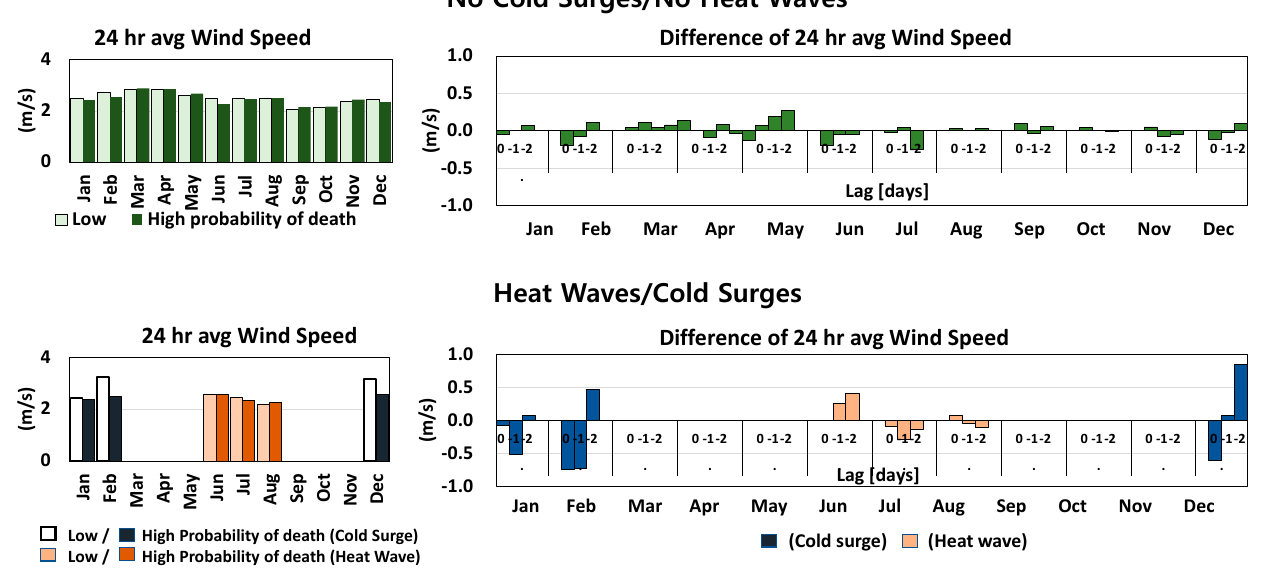
Figure 13. Comparison of monthly average precipitation on days of high and low probability of death and the differences in precipitation (precipitation (high probability of death) –precipitation (low probability of death) ) from zero to two days before death. Wind speeds on H and L days differed little (Figure 14), but wind speed on H days was apparently lower than on L days when cold surges were observed in January, Febru-